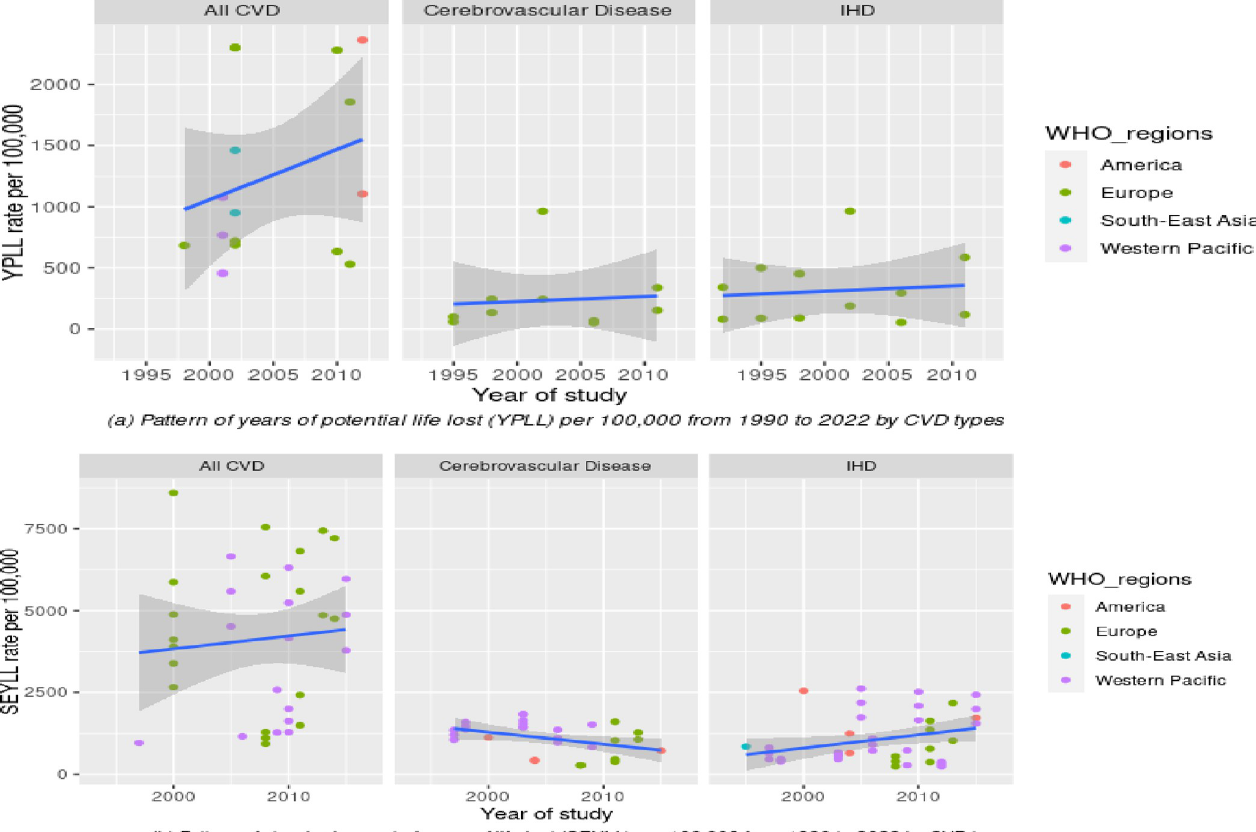
Fig 5. Patterns of YPLL rate (a) and SEYLL rate (b) according to CVD types and WHO regions.